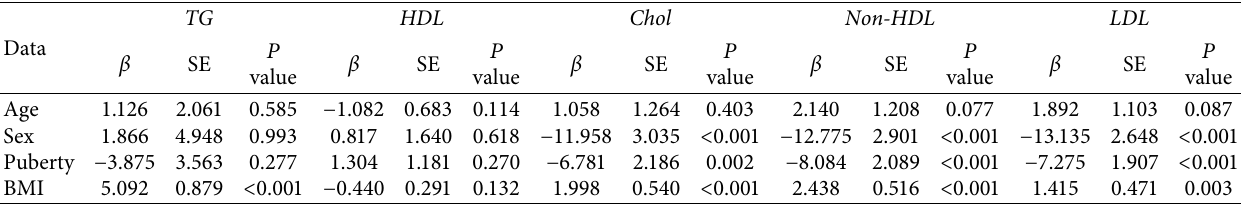
Table 3: Linear regression analysis for the efect of age, sex, stage of puberty, and BMI on lipid profle. P values less than 0.05 are shown in bold. All of lipid concentrations are in